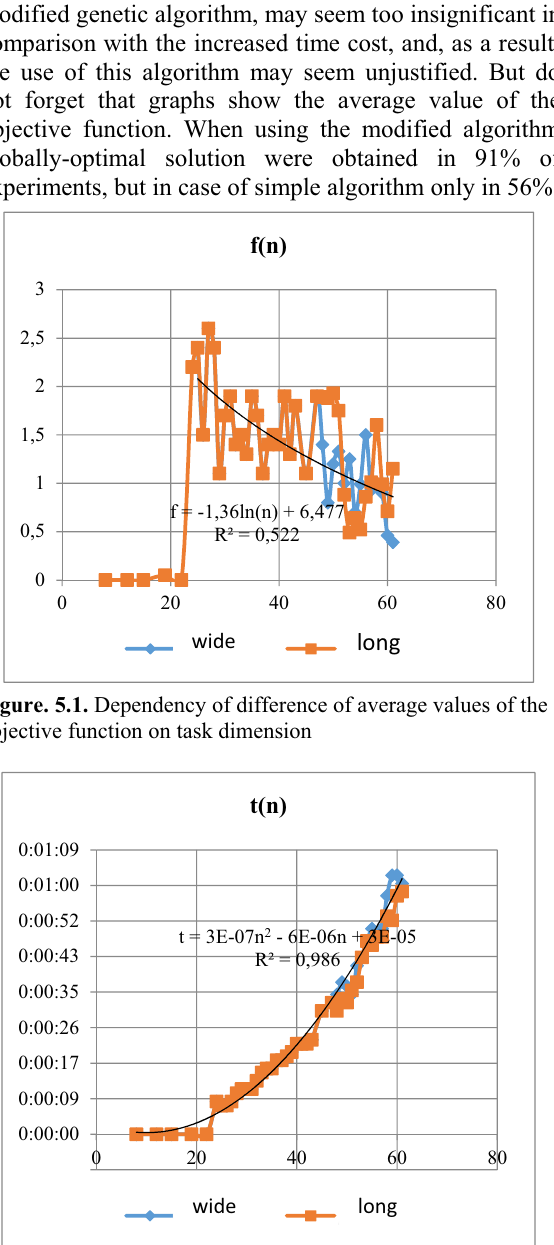
Figure. 5.2. Dependency of difference of average value of searching time on task